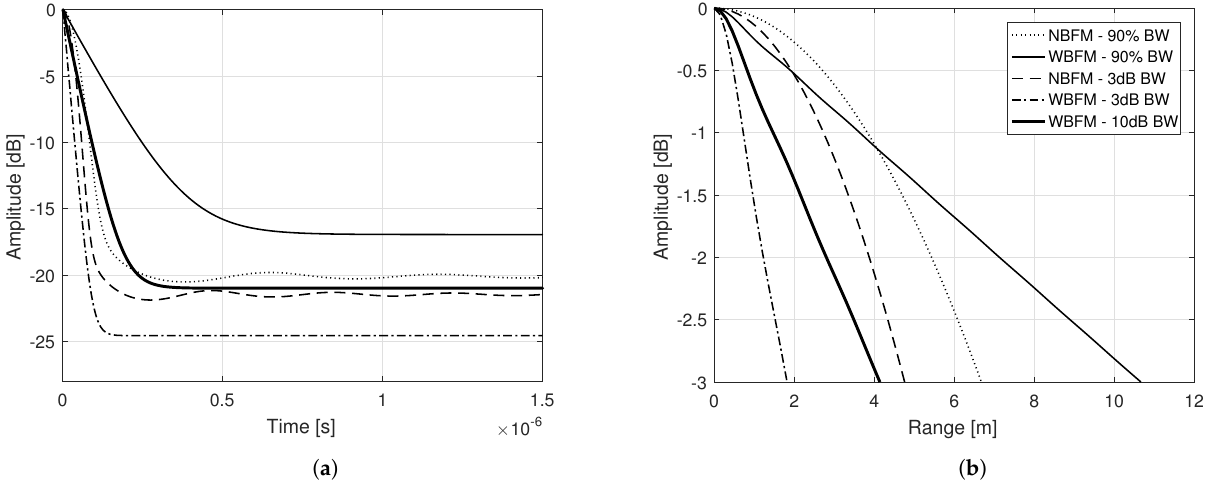
Figure 3. ( a ) Matched filter output powers and ( b ) their corresponding 3 dB widths brought on focus of narrowband (NBFM) and wideband (WBFM) frequency modulated signals with 10 µ s duration, considering different combinations of σ a and B a that result in bandwidths B ˜ s = 10 MHz under different